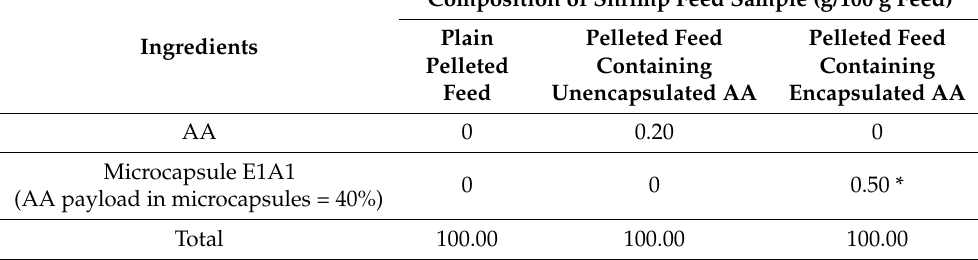
Composition of Shrimp Feed Sample (g/100 g